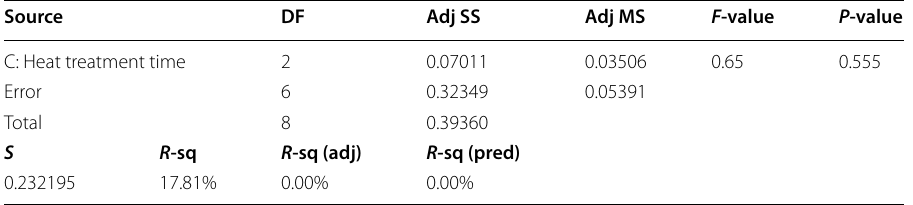
Table 7 One-way ANOVA results for the heat